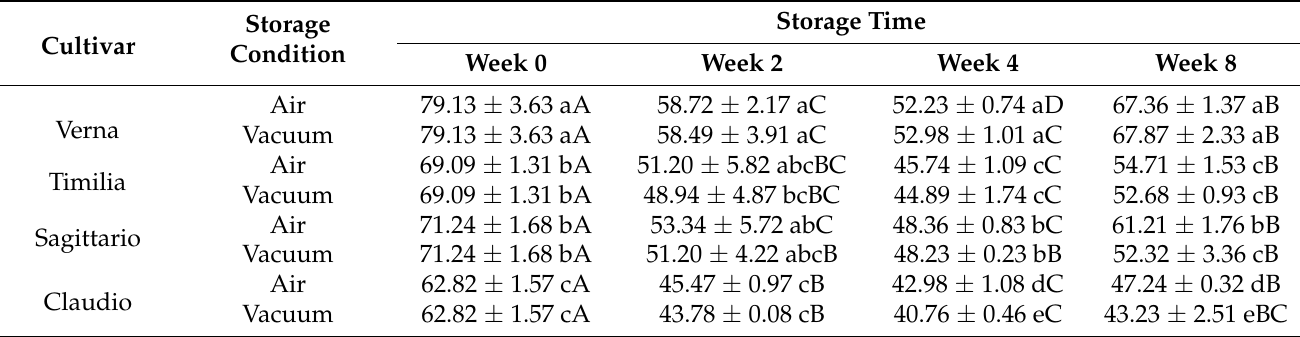
Table 3. Total flavonoid contents expressed as catechin equivalents of four wheat cultivars (mg/100 g) stored under different conditions and for different lengths of